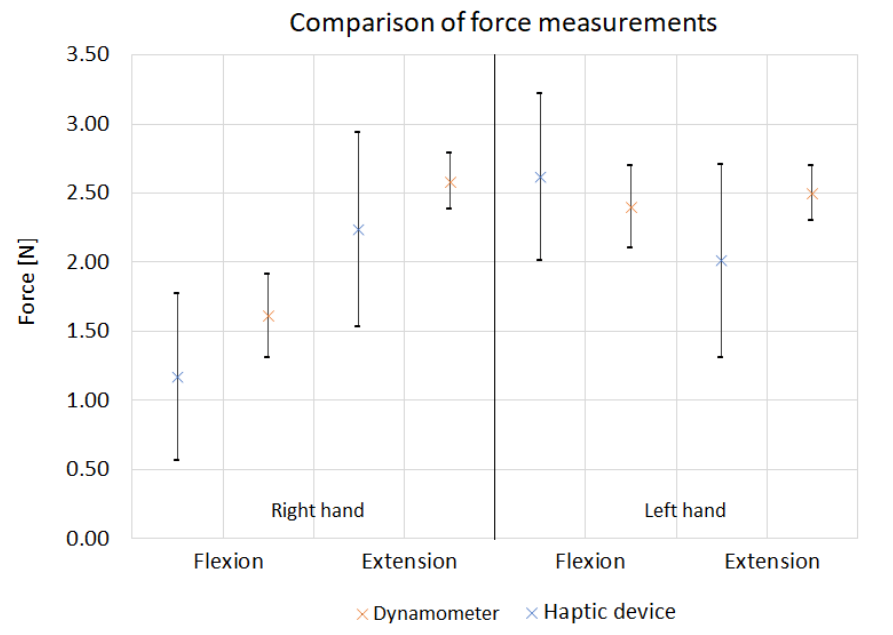
Figure 12. Comparison of force measurements via Haptic device and